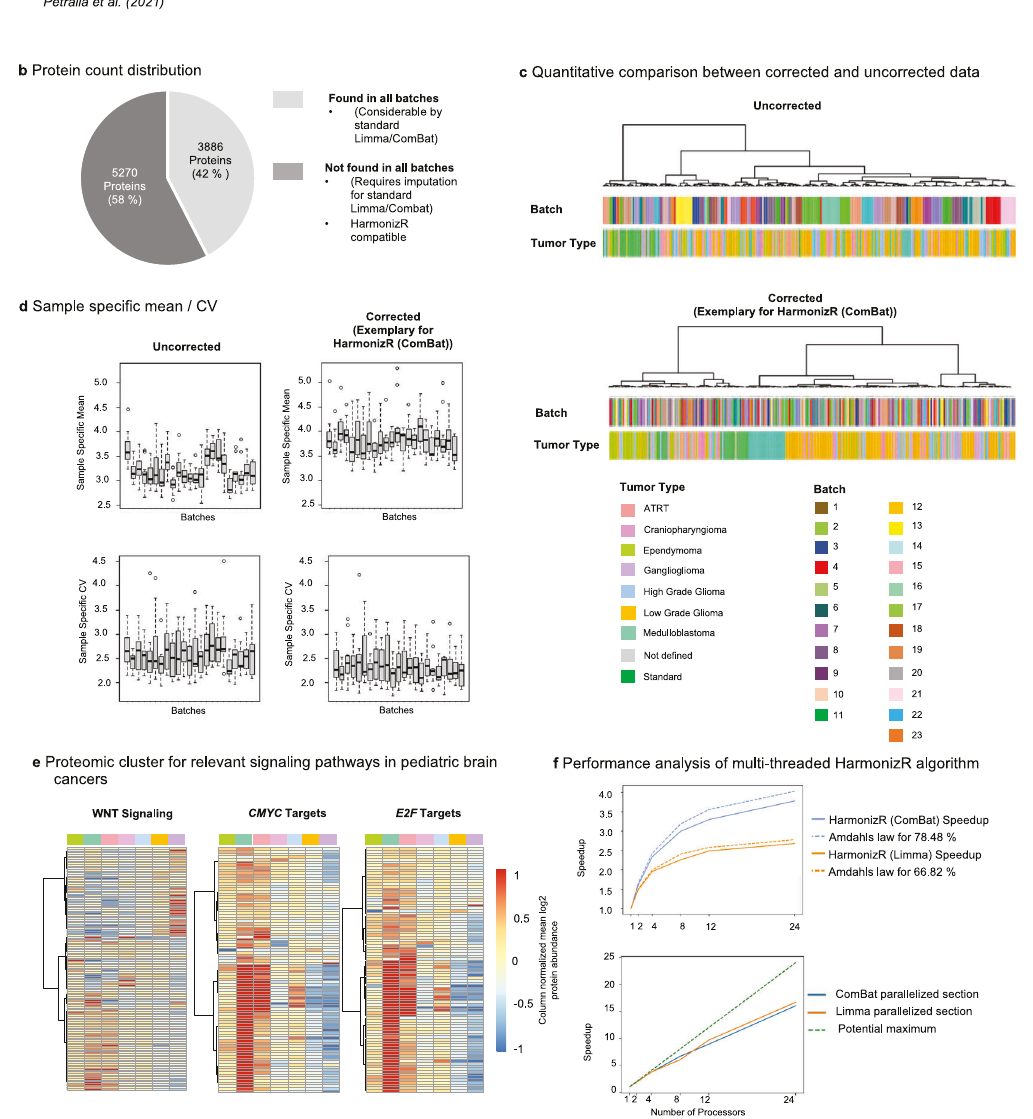
mass spectrometer (Orbitrap Fusion, Thermo Fisher Scienti fi c) 23 . The dataset is available through the Clinical Proteomic Tumor Analysis Consortium Data Portal (https://cptac-data-portal.georgetown.edu/cptacPublic/) and the Proteomics Data Commons (https://pdc.cancer.gov/pdc/). Experimental setup for in house generated datasets . For the comparison of HarmonizR to established missing value handling strategies, an arti fi cial mixed organism proteome with expected foldchange differences was generated